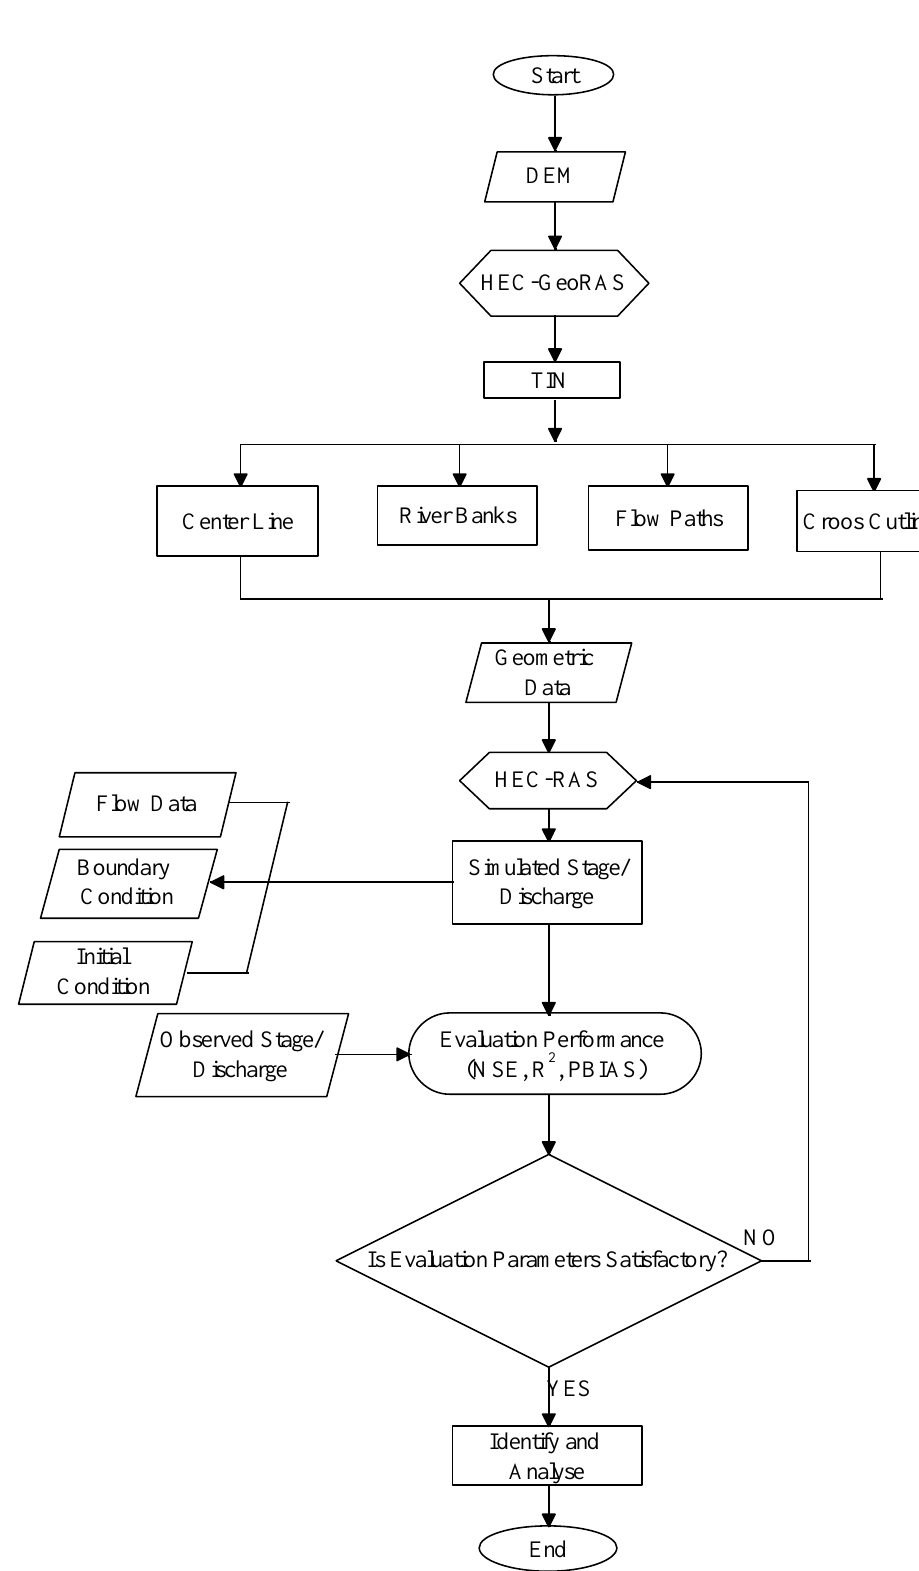
Figure 5. Hydrologic Engineering Centers River Analysis System (HEC-RAS) model setup for simulation of available canal flow.